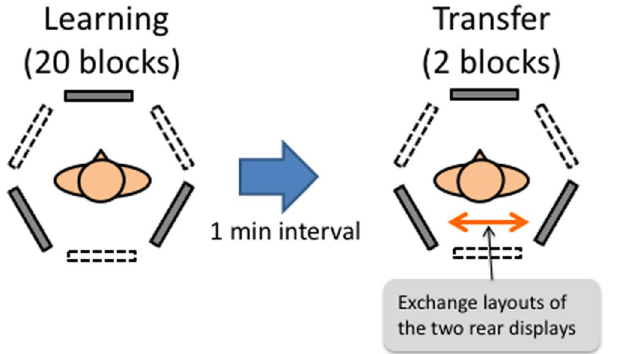
Figure 4. Experiment with three displays to examine the context effect of 0° display on the target location on ± 120° displays. After 20 blocks of visual search with three displays, layouts of the ± 120° were exchanged in transfer blocks. In the transfer blocks, RT should be lengthened if the observer tries to use the memorized relationship between the 0° display and the target on the ± 120°